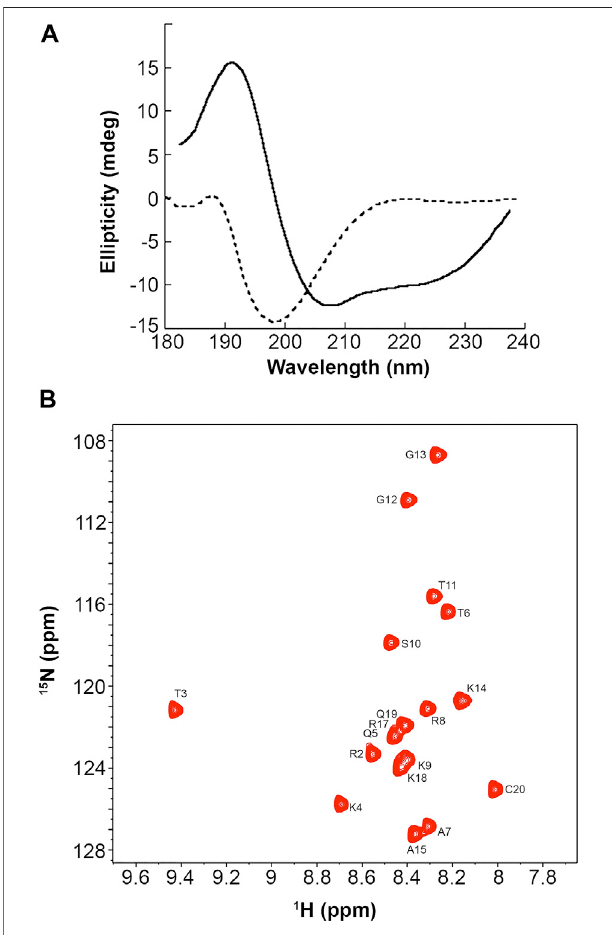
FIGURE 2 | CD and NMR spectra of a synthetic PMM-modi fi ed H3 (1 – 19) peptide with sequence ART phos K me3 QTAR me2 KSTGGKAPRKQC. (A) : CD spectra of the peptide at 12 ° C in 20 mM phosphate buffer, 1 mM TCEP, pH (cid:2) 6.9 (dashed line) and in 90% aqueous TFE (solid line). (B) :